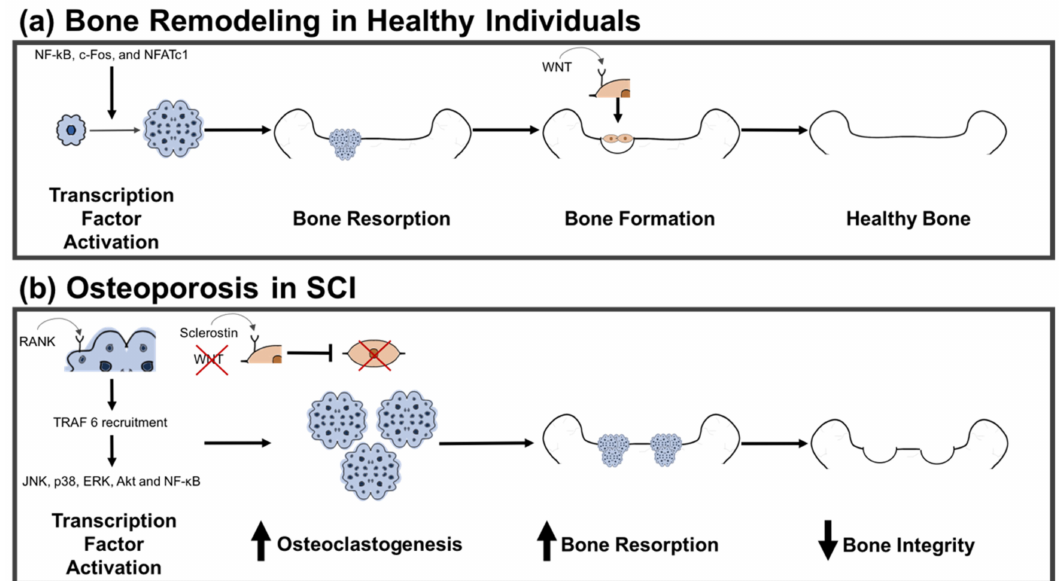
Figure 1. Typical bone remodeling vs. bone remodeling in individuals with spinal cord injury (SCI). ( a ) In individuals without SCI, bone remodeling is typically a balanced process. Transcription factors nuclear factor- κ B (NF-kB), c-Fos, and nuclear factor of activated T-cells, cytoplasmic 1 (NFATc1) secreted by osteoblasts are activated, stimulating the mat- uration of mononucleated osteoclast progenitors. Mature osteoclasts secrete cathepsin K and hydrochloric acid (HCl) to dissolve the bone matrix, with resulting calcium resorption. Moreover, Wnt protein can bind to receptors on osteoblasts. Upon activation, osteoblasts form a layer across the surface of the dissolved bone for calcification. When these processes are coupled, bone integrity is preserved. ( b ) In individuals with SCI, bone remodeling is no longer balanced, resulting in osteoporosis. Receptor activator of nuclear factor- κ B (RANK) ligand binds to RANK receptors on osteoclasts, inducing TNF receptor-associated factor 6 (TRAF-6) recruitment and activation of transcription factors c-Jun N-terminal kinase (JNK), p38, extracellular signal-regulated kinase (ERK), alpha serine-threonine protein kinase (Akt) and NF- κ B. These factors participate in various cellular signaling pathways to induce osteoclastogenesis. Furthermore, Wnt protein may be unable to bind due to the presence of Wnt-receptor competitive inhibitors (e.g., sclerostin (SOST)), preventing osteoblast activation. Therefore, increased bone resorption occurs without osteoblast-mediated bone construction. Bone integrity is compromised with resulting